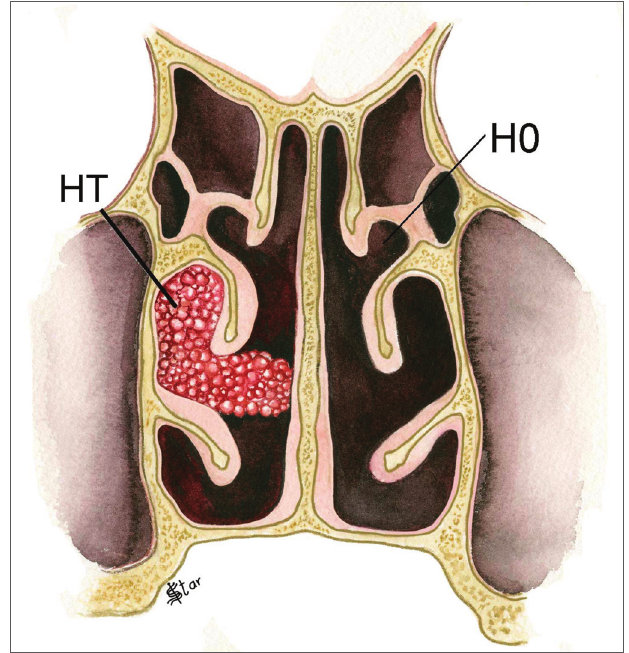
Figura 2. Estadiamento da PN no plano Horizontal - H0 -